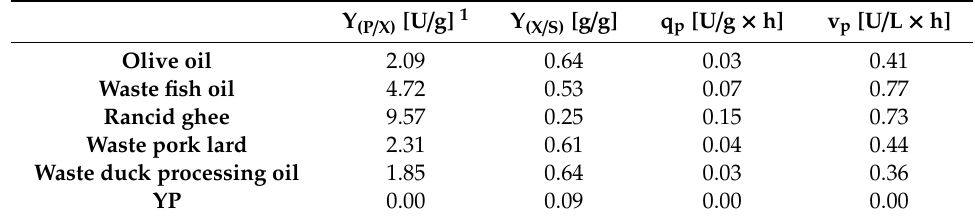
Table 2. Selected culture parameters of C. cylindracea in media with lipid-rich food industry wastes as carbon